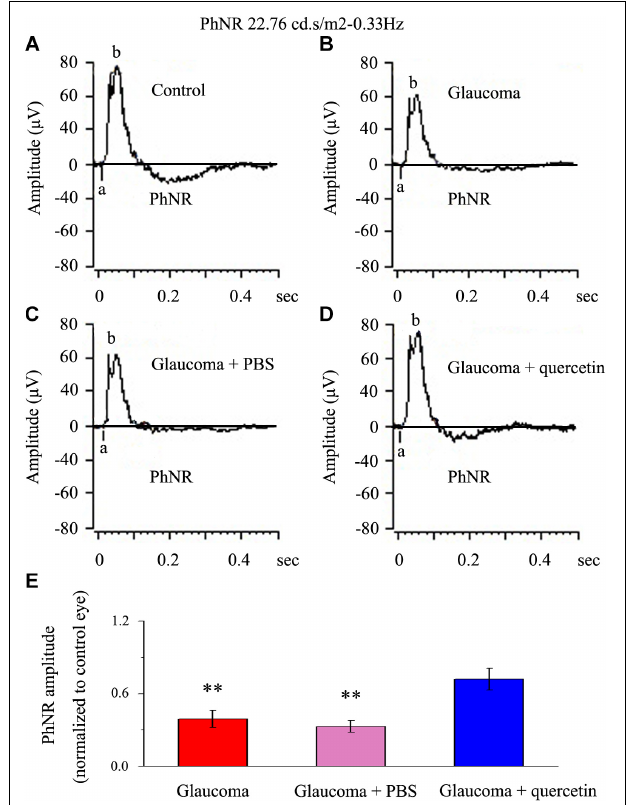
FIGURE 1 | PhNR of normal and glaucomatous rat eyes. (A,B) Representative traces of the “a” wave, the “b” wave, and PhNR in a control eye (A) and a glaucomatous eye (B) in step 3 with the stimulus applied at 22.76 cd.s/m 2 –0.33 Hz. (C,D) Representative waves in a PBS-treated glaucomatous eye (C) and quercetin-treated glaucomatous eye (D) in the same step and with the same stimulus used in (A,B) . (E) Quantitative analysis of PhNR amplitude ( n = 12). The amplitude was normalized to the amplitude in control retinas. ∗∗ p < 0.01 (one-way analysis of variance). a, “a” wave; b, “b” wave; PhNR, photopic negative